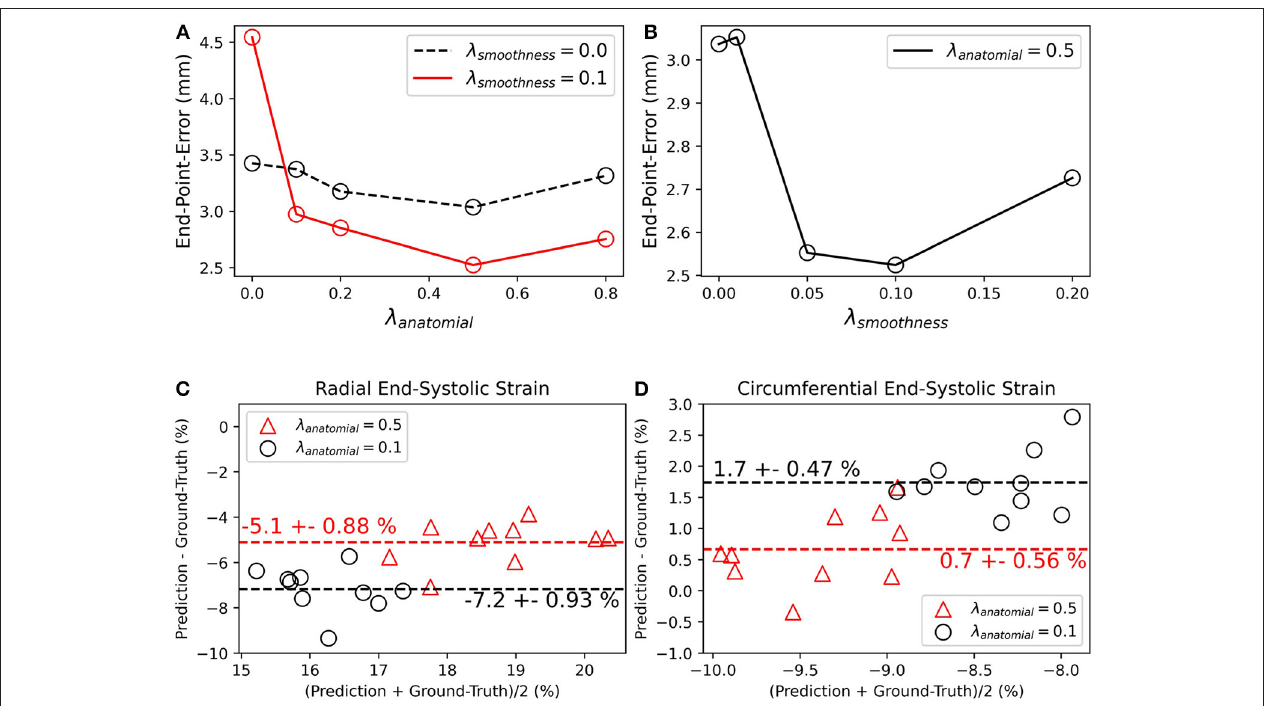
FIGURE 4 | Quantitative effects of regularization on the accuracy of motion and myocardial strain. (A,B) End-point-error on MRXCAT test data with ground-truth motion for CarMEN with varied (A) anatomical and (B) smoothing regularization parameters. (C,D) Bland-Altman plots of radial and circumferential end-systolic strain for two different anatomical regularization parameters, and smoothing set to